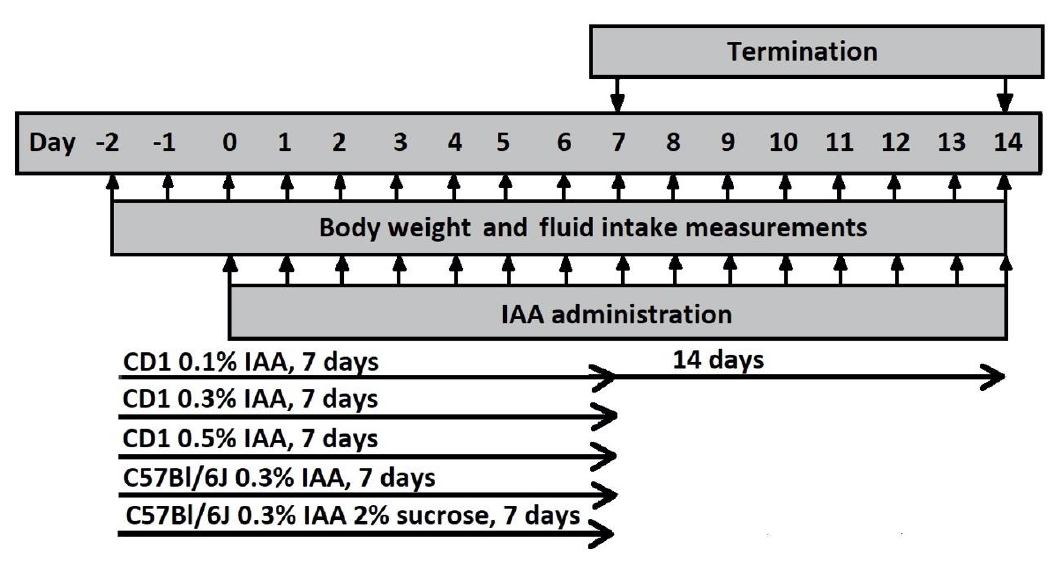
Figure 10. Experimental design of IAA gastritis with CD1 and C57Bl / 6J mice. Male CD1 and C57Bl / 6J mice were divided into groups receiving various concentrations (0.1%, 0.3% and 0.5%) of IAA dissolved in drinking water. Control mice received tap water. Body weight and fluid intake were monitored daily throughout the experiment. At the end of the protocol, mice were euthanized and their stomachs were excised for macroscopic and microscopic